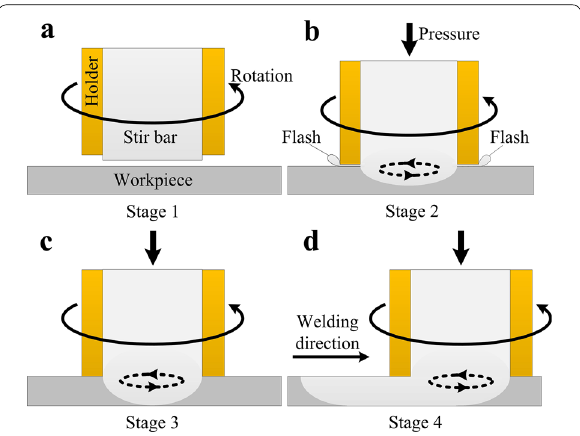
Figure 2 Schematic of the welding process in Vortex-FSW: a rotating; b pressuring; c dwelling; d